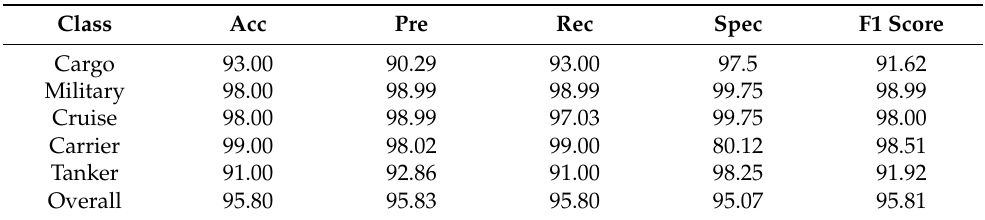
Table 4. Evaluation metrics of proposed classification algorithm for the game of deep learning sea ship dataset.